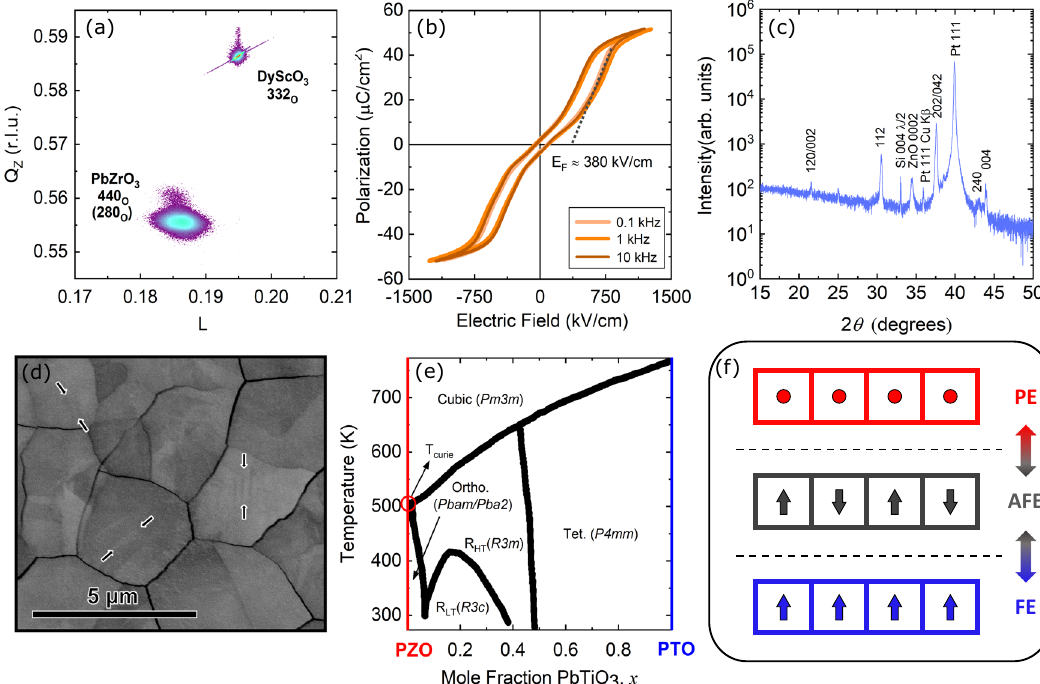
Fig. 1 Structural phase transformations in PZO upon electrical and thermal stimuli. a Reciprocal space map of the PbZrO 3 440/280 O and DyScO 3 332 O re fl ections demonstrating epitaxial growth and the presence of ferroelastic domains in the epitaxial fi lm. b Polarization-electric fi eld hysteresis response for the epitaxial PbZrO 3 fi lm showing antiferroelectric switching. c 2 θ - ω XRD pattern for the polycrystalline PbZrO 3 fi lm. d Channeling-contrast backscatter electron micrograph of the polycrystalline PbZrO 3 fi lm. The arrows indicate the locations of clearly resolved ferroelastic domains. e Phase diagram for lead zirconate titanate (PbZr 1 − x Ti x O 3 , PZT) recreated from ref. 27 . f Schematic of dipole orientation across antiferroelectric to ferroelectric (AFE-to-FE) and antiferroelectric to paraelectric (AFE-to-PE) phase